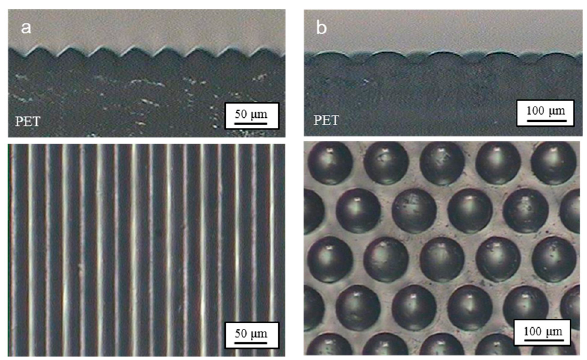
Figure 7. Microscopic images of the replicated micropatterns: ( a ) prism pattern; ( b ) dot pattern.